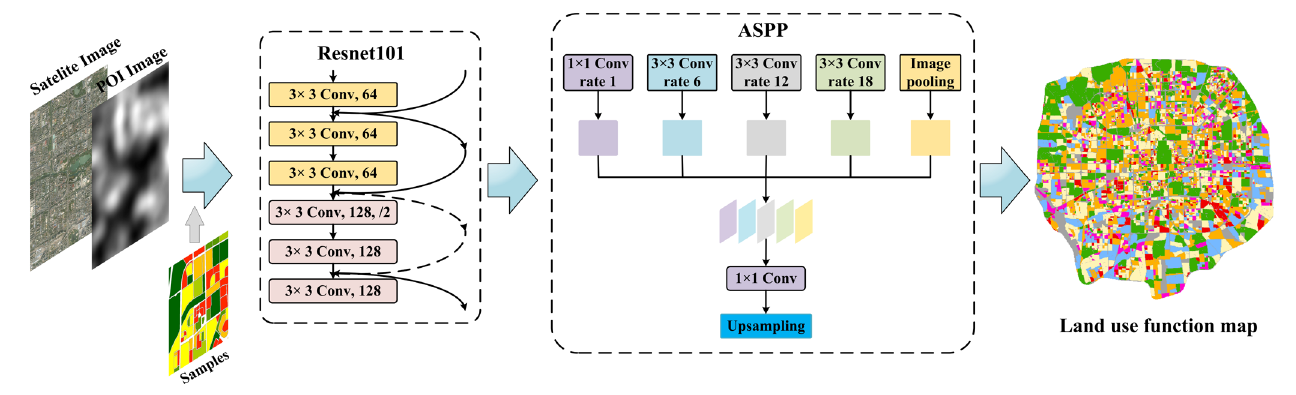
Figure 4. Segmentation framework for recognizing land-use functions.